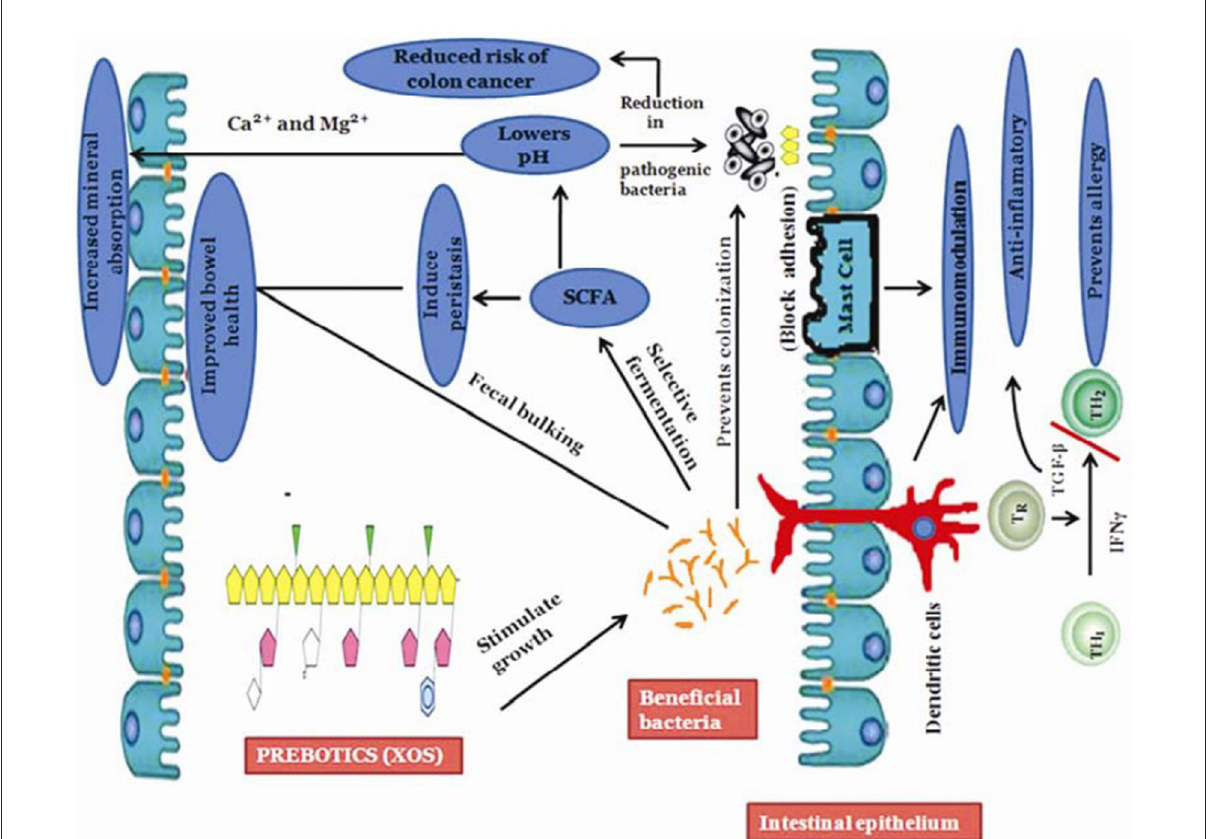
FIGURE5 Illustration of benefits incurred by prebiotics on immune system: Stimulates growth of the beneficial bacterium in the large intestine that prevents colonization of harmful bacteria; increases production of short-chain fatty acids (SCFA) and helps in improving bowel health that reduces risks of colon cancer [Adopt from Slizewska et al.